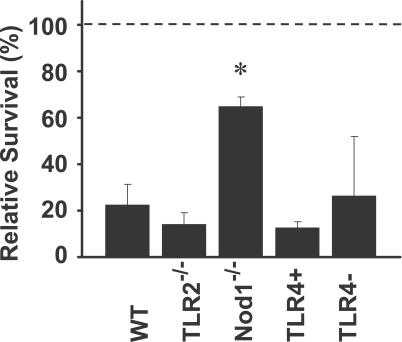

Hi-Enhanced Opsonophagocytic Killing of Sp Requires Nod1Neutrophil-enriched PECs were obtained from C57Bl/6 mice (WT) or congenic mice lacking TLR2 or Nod1. C3H mice with functional or non-functional TLR4 were also compared. The effect of i.p. administration of heat-inactivated whole Hi636 in casein on the ability of neutrophil-enriched PECs to kill Sp1121 is shown relative to controls where neutrophil-enriched PECs were elicited by casein administration alone. Values represent ≥ three independent determinations in duplicate ± SD. *p < 0.05 compared to other groups of the same genetic background.